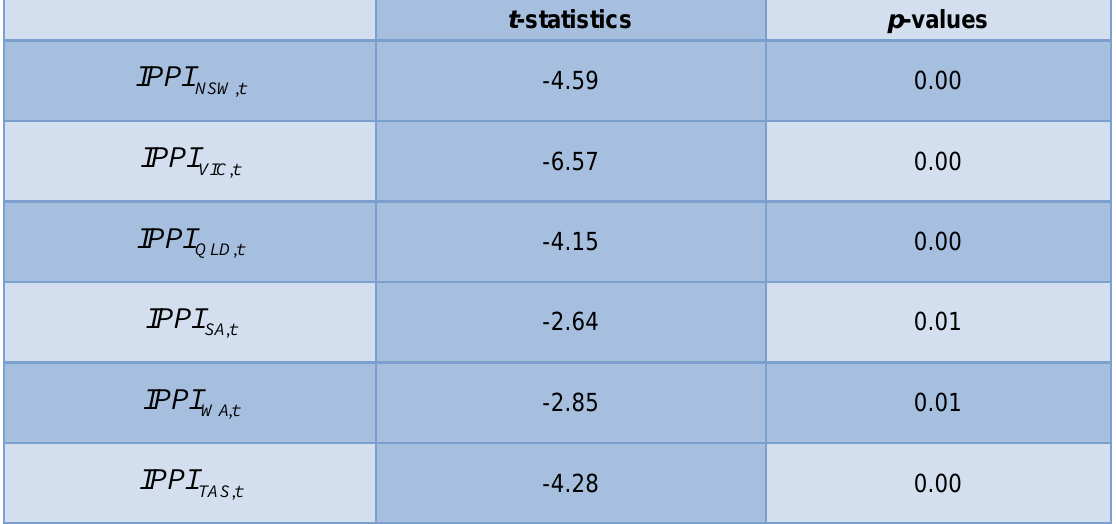
Table 3 t-statistics and p-values of the coefficients of the independent variables According to the coefficients in Eq. (10), the new housing commencements are sensitive